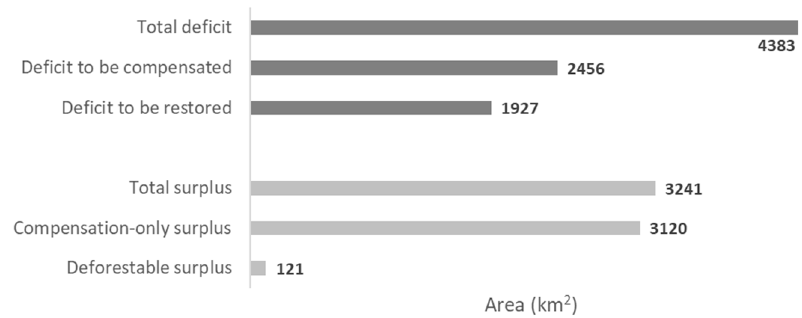
Figure 6. Legal reserve deficit and surplus estimates in rural properties registered under CAR and in Incra settlements, as defined by Brazilian environmental law (Law no. 12651, 25 March 2012), across the Itacaiúnas watershed.